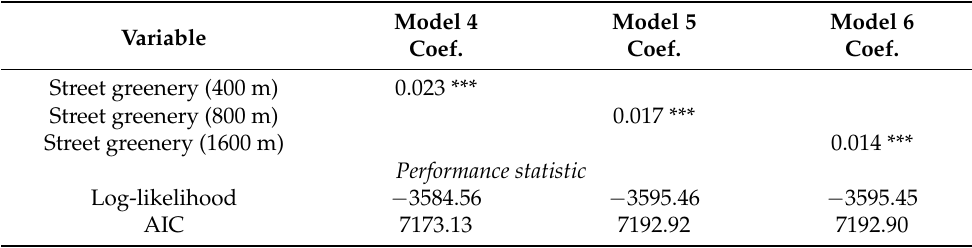
Table A1. Box–Cox transformation modeling